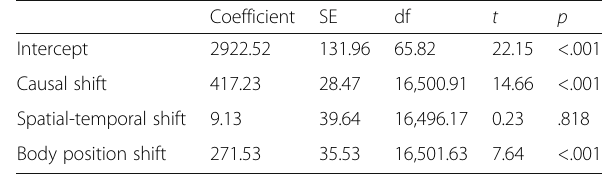
Table 5 Results from linear mixed effects model